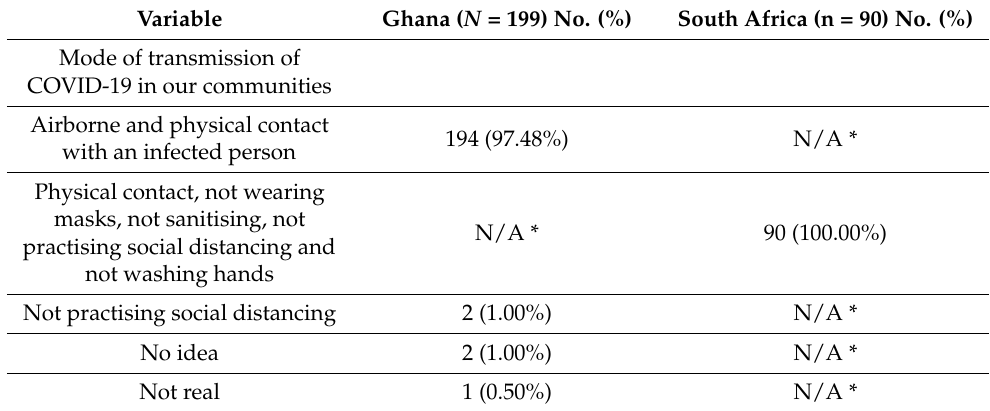
Table 4. Perceived mode of transmission of COVID-19 within our communities. Variable Ghana ( N = 199) No. (%) South Africa (n = 90) No. (%) Mode of transmission of COVID-19 in our communities Airborne and physical contact with an infected person